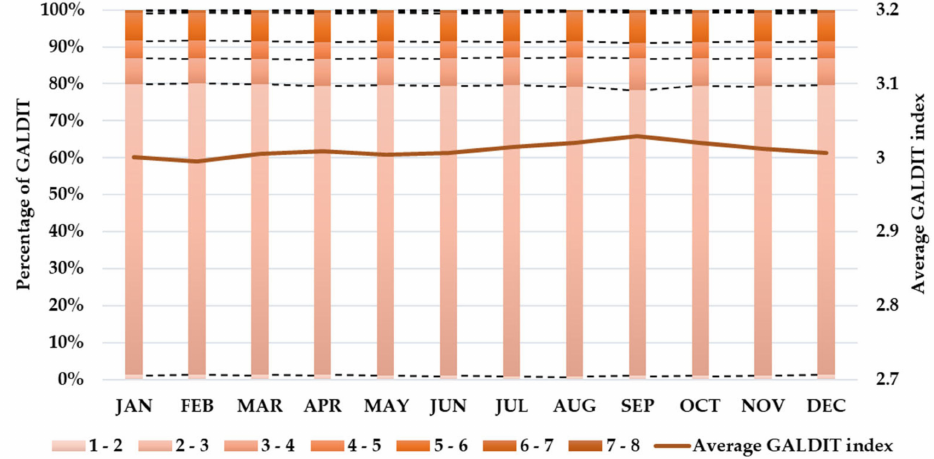
Figure 12. Distribution of 10-year-averaged monthly GALDIT